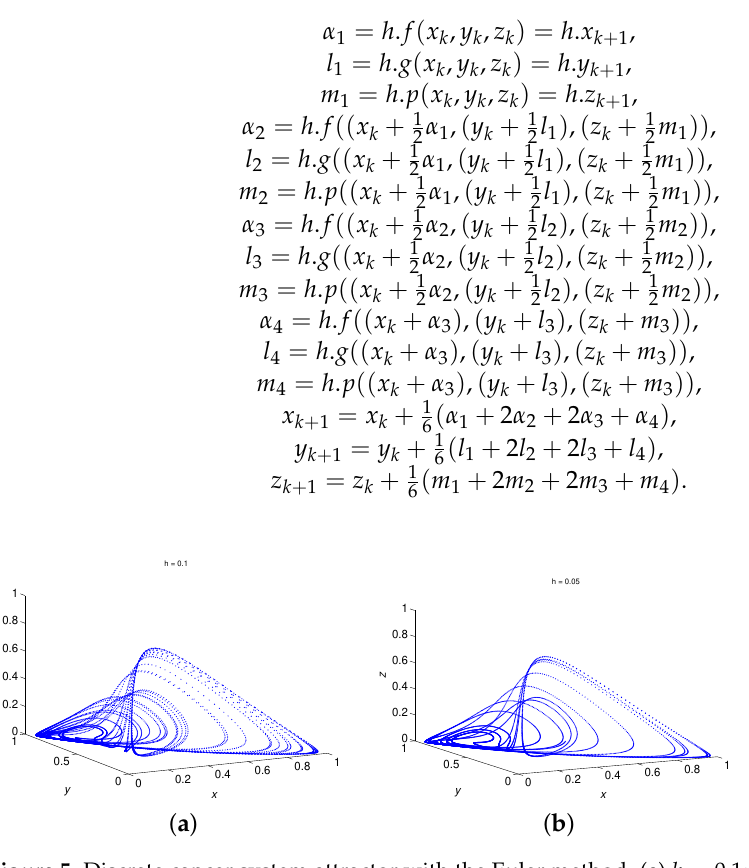
Figure 5. Discrete cancer system attractor with the Euler method. ( a ) h = 0.1; ( b ) h = 0.05.